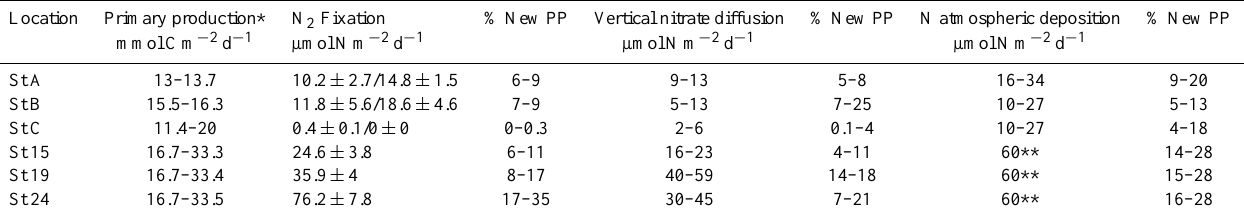
Table 1. Integrated primary production, N 2 fixation, vertical nitrate diffusion at the base of the euphotic zone and atmospheric deposition at stations A, B, C, 15, 19 and 24 and percentage of estimated “new” primary production (New PP) sustained by each source of “new” nitrogen. New PP (expressed in µmolNm − 2 d − 1 ) has been considered as 10% of total PP (Moutin and Raimbault, 2002).